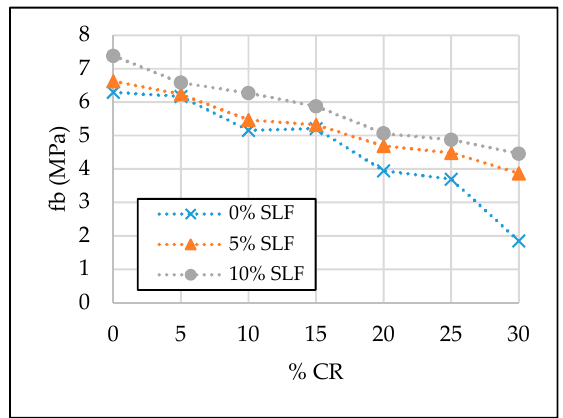
Figure 14. The e ff ect of crumb rubber and silica fume on 28-day flexural Figure 14. The effect of crumb rubber and silica fume on 28-day flexural strength.